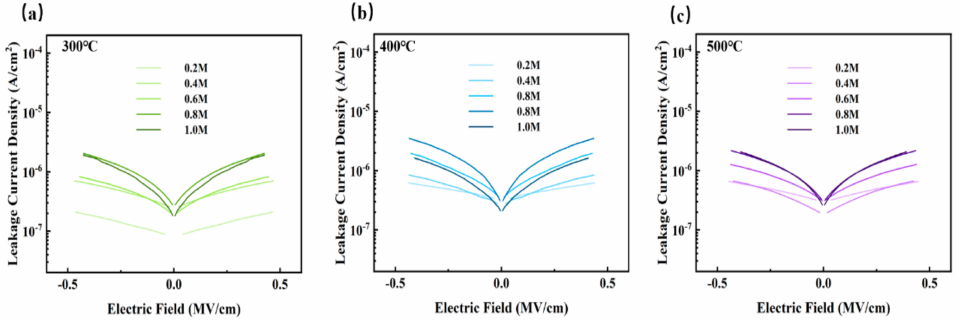
Figure 11. ZYAMO thin film leakage current density after different temperature annealing: ( a ) 300 ◦ C,